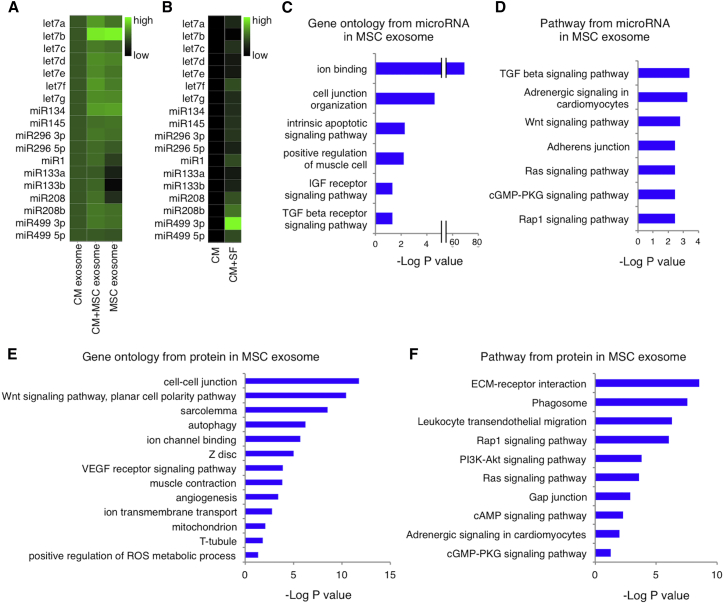
MicroRNAs and Proteins in hMSC-Derived Exosomes(A and B) Expression of microRNAs reported to promote the maturation of cardiomyocytes (let7 family, microRNA134, microRNA145, microRNA296) or to be specific to cardiomyocytes (microRNA1, microRNA133, microRNA208, microRNA499) in exosomes from culture media containing differentiated cardiomyocytes (CM), cardiomyocytes co-cultured with MSCs (CM+MSC), or MSC (A); and in CM or cardiomyocytes cultured with MSC-derived soluble factors (CM+SF) (B). (C and D) Gene ontology (C) and pathway analysis (D) of the microRNAs associated with the maturation of cardiomyocytes. The vertical axes show the gene ontology category and pathway category, respectively, and the horizontal axes show the extent of enrichment of each gene ontology category or pathway, respectively. (E and F) Gene ontology (E) and pathway analysis (F) of proteins in hMSC exosomes. The vertical axes show the gene ontology category and the pathway category, respectively, and the horizontal axes show the extent of enrichment of each gene ontology category or pathway, respectively.